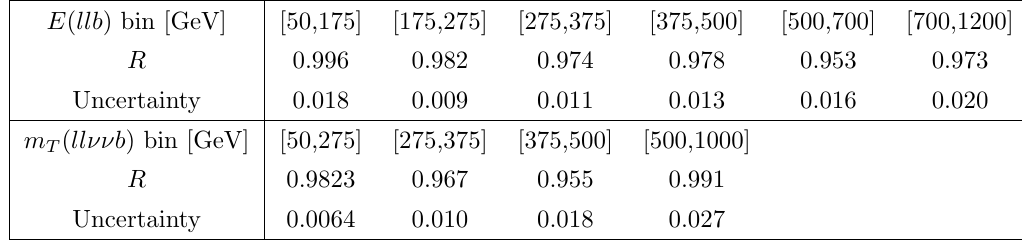
Table 3 . SM prediction for the (cid:13)avour ratio in eq. (6.1) taken from 1.2 M Monte Carlo events. Uncertainties are purely